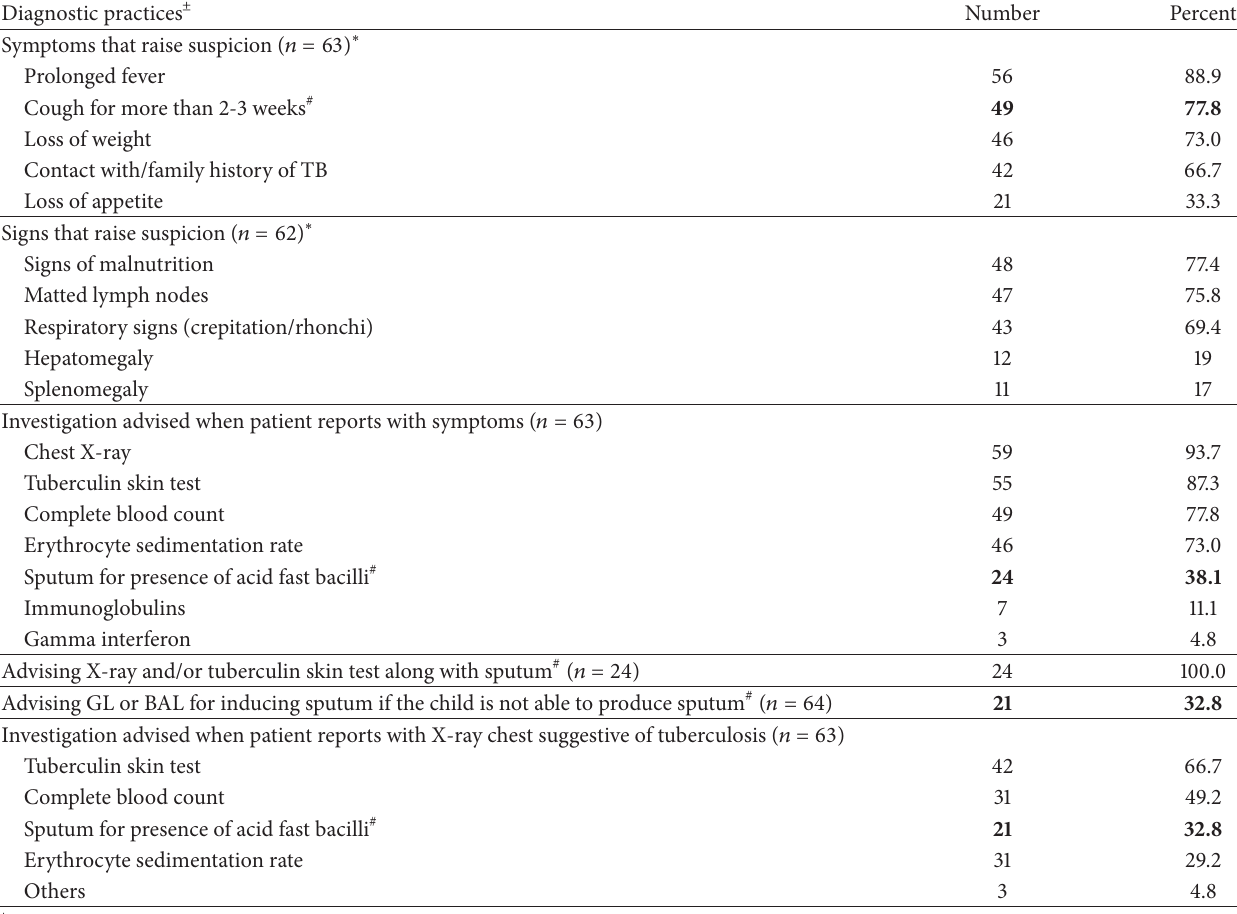
Table 3: Practices related to diagnosis of pulmonary tuberculosis in a child as reported by paediatricians in Mumbai. Diagnostic practices